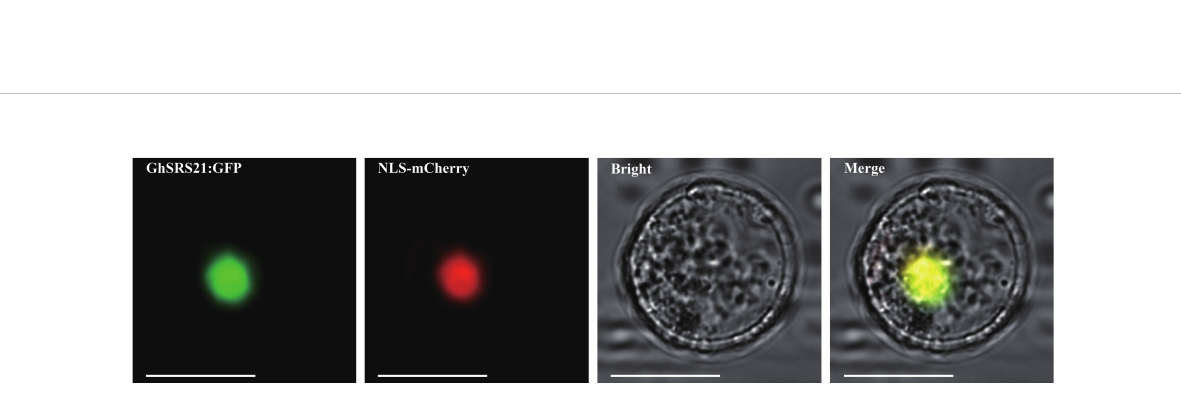
FIGURE 6 Subcellular location of GhSRS21. NLS-mCherry: nuclear localization sequence fused with a reporter gene mCherry, which is used as nuclear localization marker. Bar=10 m m.